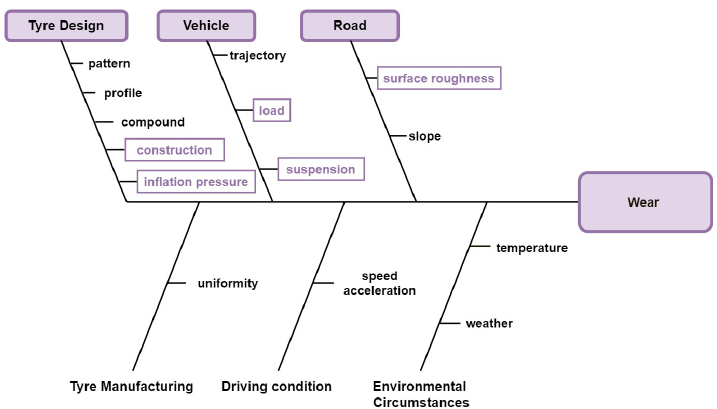
Figure 1. Internal and external factors related to tyre wear. The highlighted ones are where the emphasis of this work